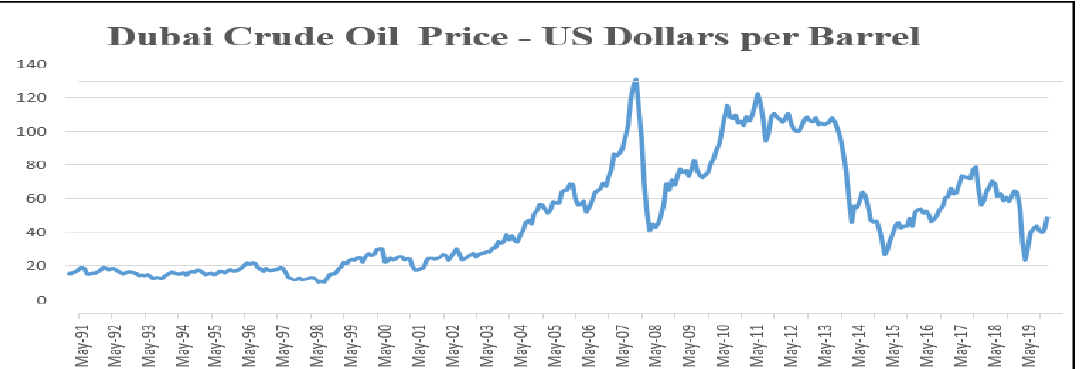
Figure 3. Graphical Expression for the Data of Dubai Crude oil Price per barrel (in USD) during 1990 to 2020; Sources: Compiled from https://fred.stlouisfed.org/categoriesa (accessed on 20 May 2021) and computed using E. Views-10.